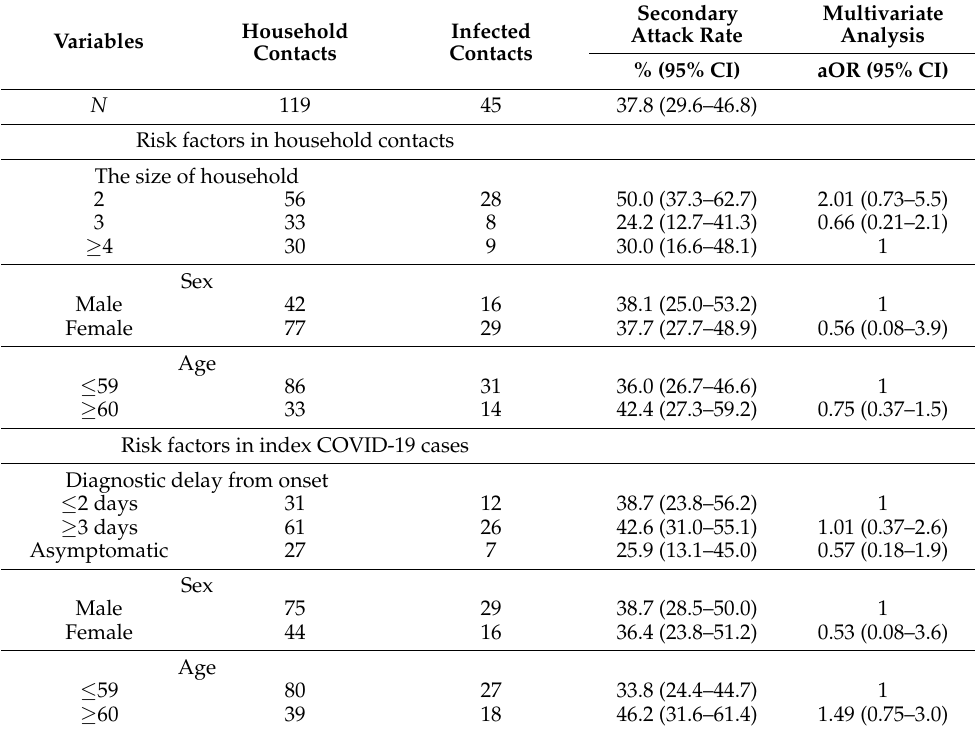
Table 4. Secondary attack rate among spouse household